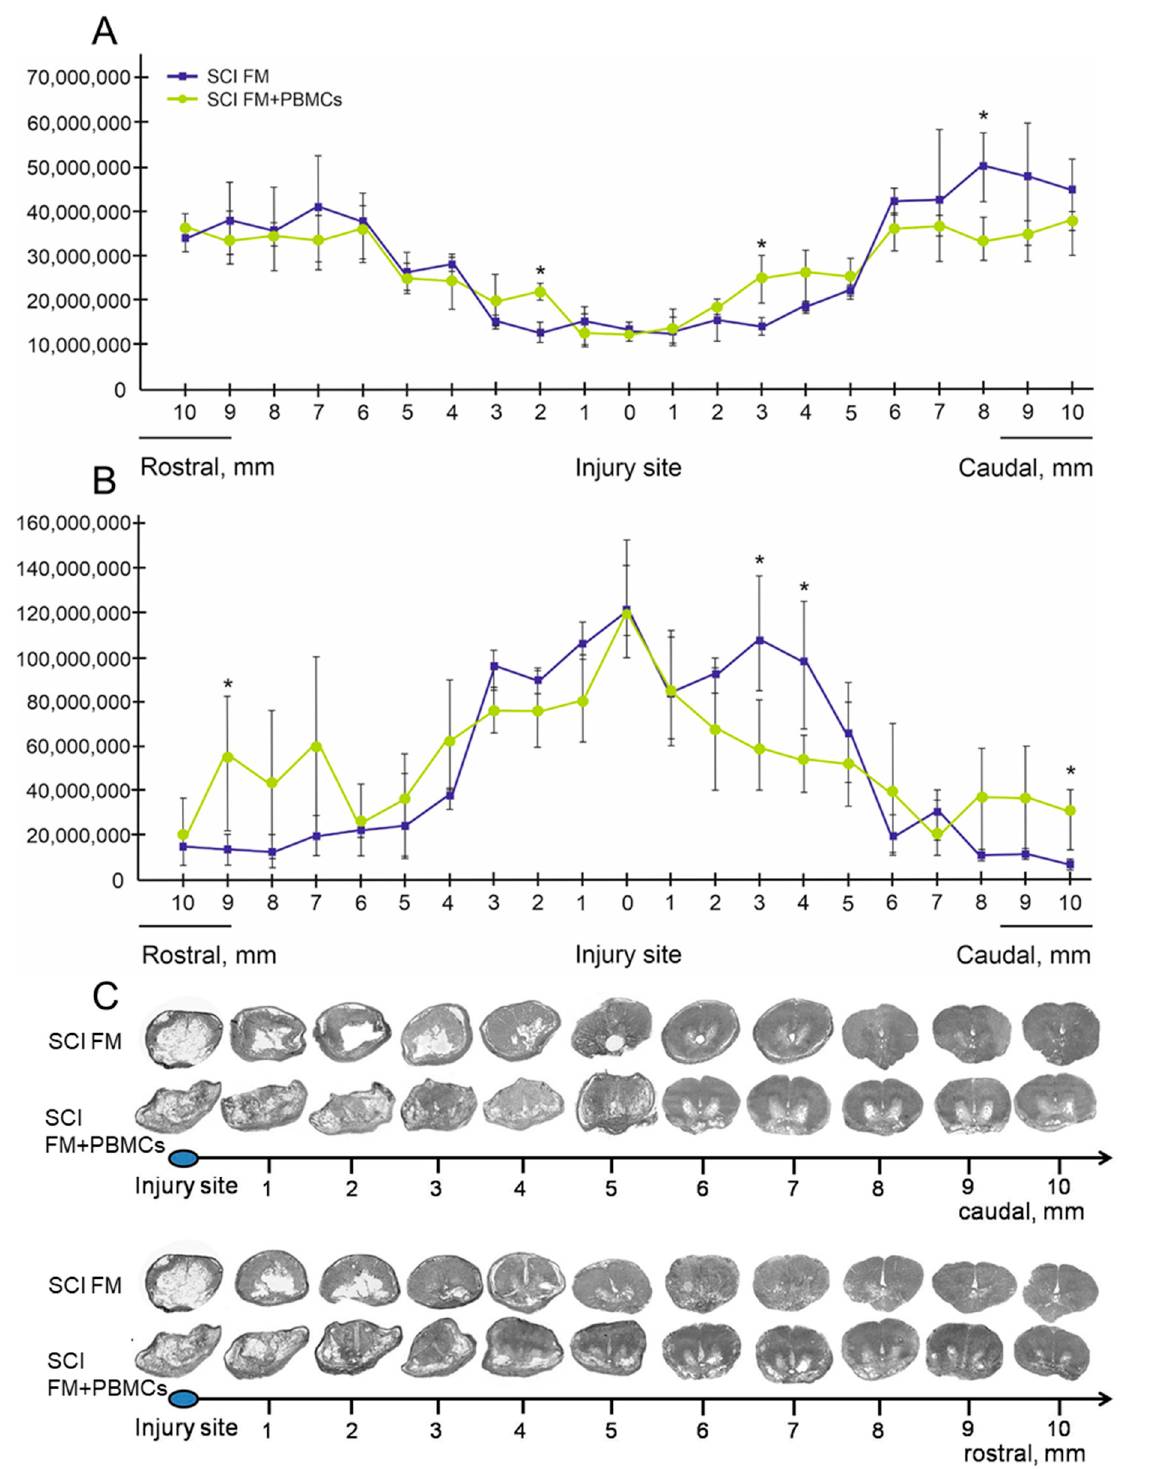
Figure 4. Spinal cord morphometry in experimental pigs. The area of spared tissue ( A ) and the total area of abnormal cavities ( B ) (Y axis, μ m 2 )10 mm rostrally and caudally from the injury epicenter 22 weeks after fibrin matrix (FM) (blue line) or FM+PBMC (yellow line) application (5 pigs in each group). * p < 0.05, one-way ANOVA followed by a Tukey’s post hoc test. ( C ) Cross-sections of the injured spinal cord at a distance of 10 mm rostrally and caudally from the injury epicenter in 22 weeks after SCIs in experimental pigs. Azur–eosin staining.